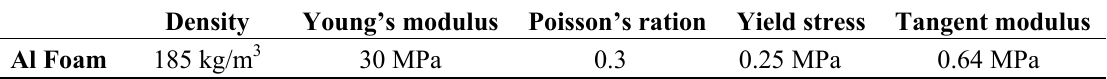
Table 2. Material properties of the metal